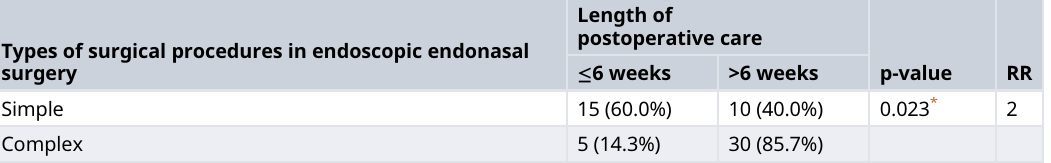
Table 4. The t-test of the length of Postoperative care for the endoscopic.